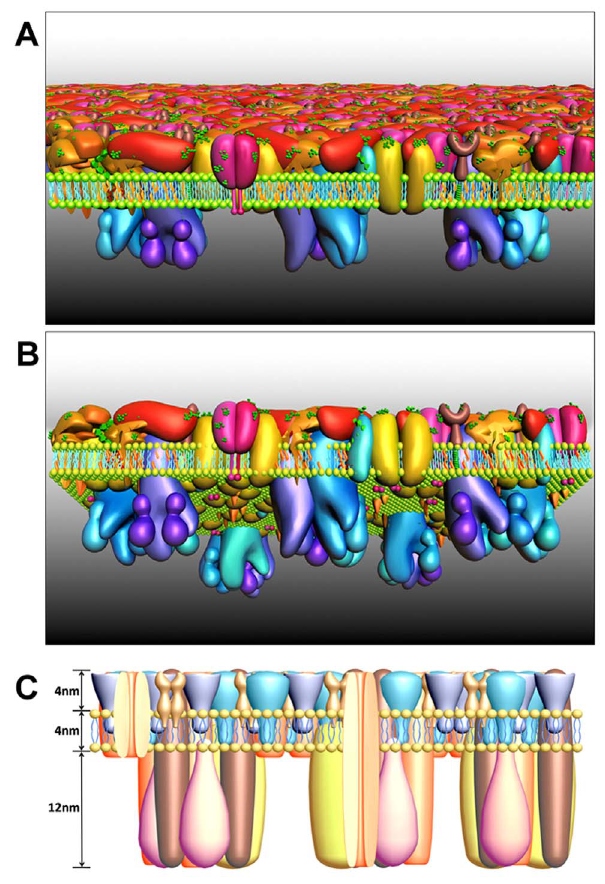
Figure 7. The proposed Protein Layer-Lipid-Protein Island (PLLPI) model of the cell membrane. (A and B) The top and bottom view of the cell membrane, respectively. The proteins on the ectoplasmic side of the cell membrane form a dense protein layer to show a smooth feature (A); the proteins on the cytoplasmic side tend to form dispersed microdomains (B). (C) The size of the cell membrane. The total height of the cell membrane is 20 nm, which is composed of the ectoplasmic protein layer (4 nm), lipid bilayer (4 nm) and cytoplasmic protein layer (12 nm).